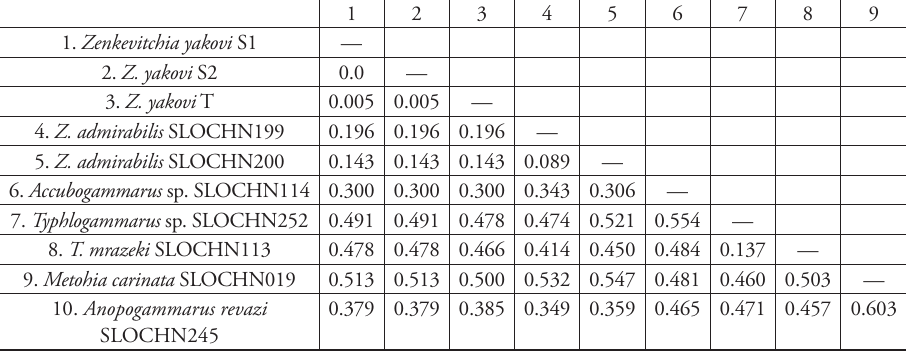
Table 3. Estimates of pairwise sequence divergence (uncorrected p -distances) of partial mitochondrial COI gene among species and haplotypes of the Balkan and Caucasian